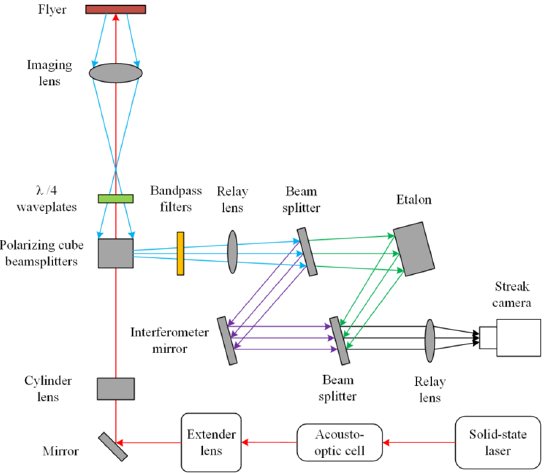
Figure 12. Schematic diagram of line ‐ VISAR.